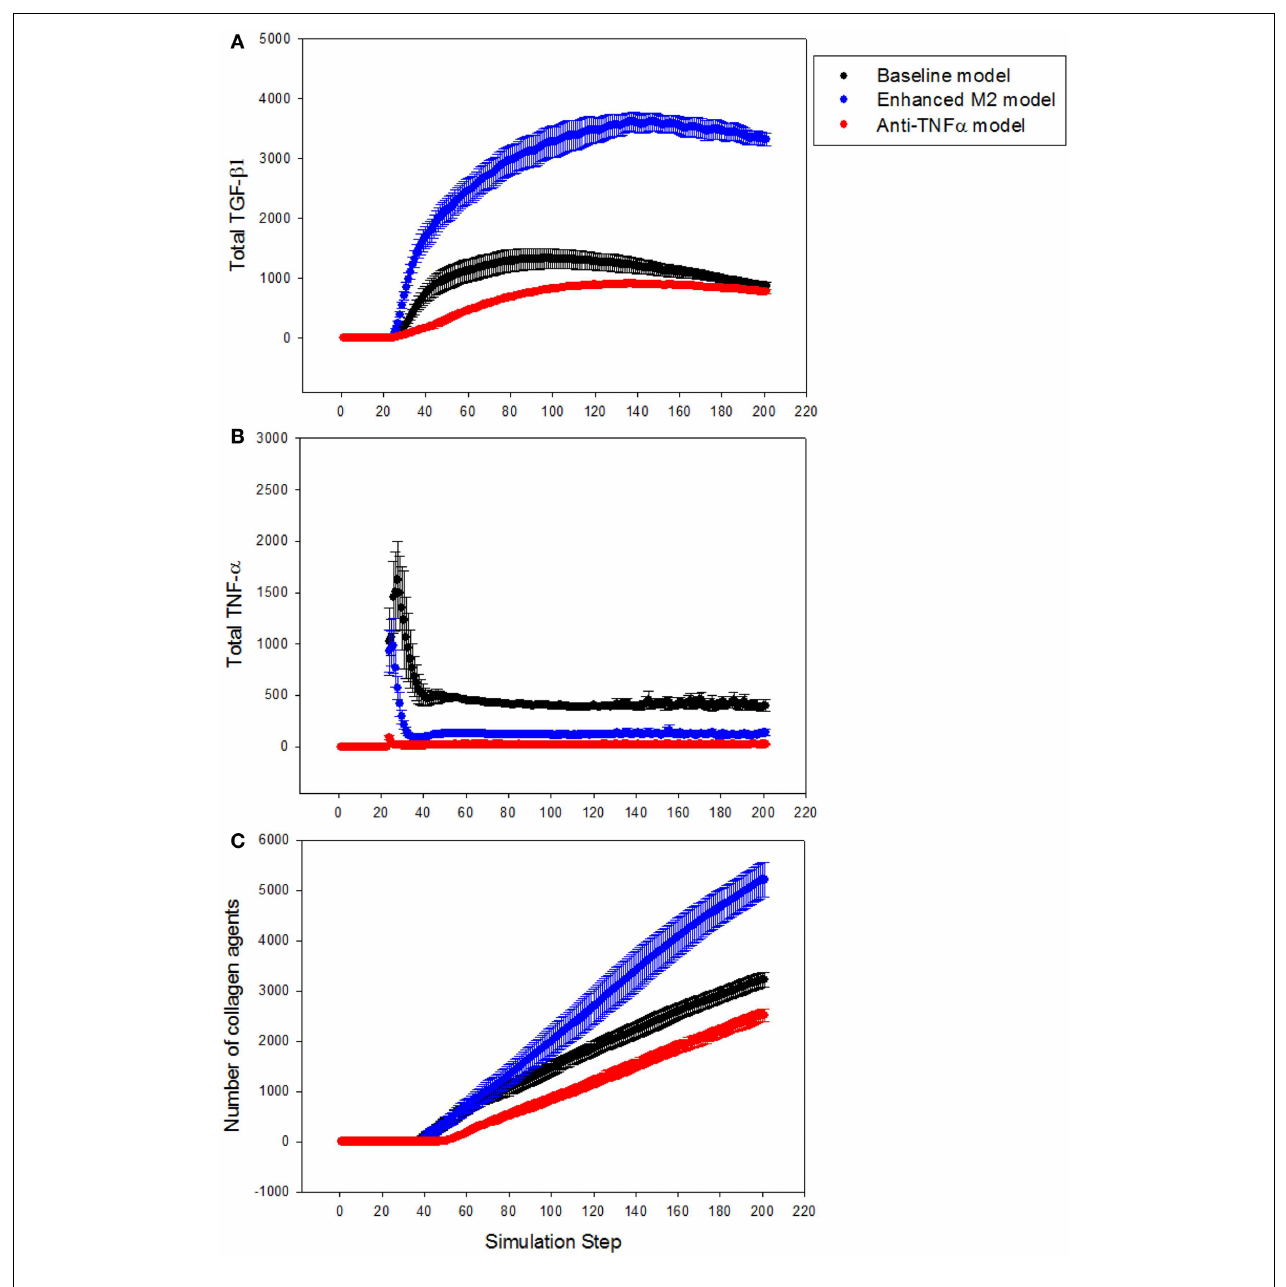
treatment (red), and in the model with enhanced M2 behavior (blue), compared toTNF- α levels in the baseline model (black); (C) growth of collagen in the anti-TNF-treated model (red), and in the model with enhanced M2 behavior (blue), compared to growth of collagen in the baseline model